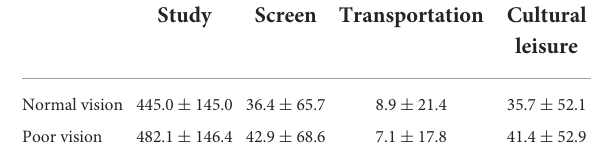
TABLE 14 Comparison of sedentary time differences among students with different vision conditions. Study Screen Transportation